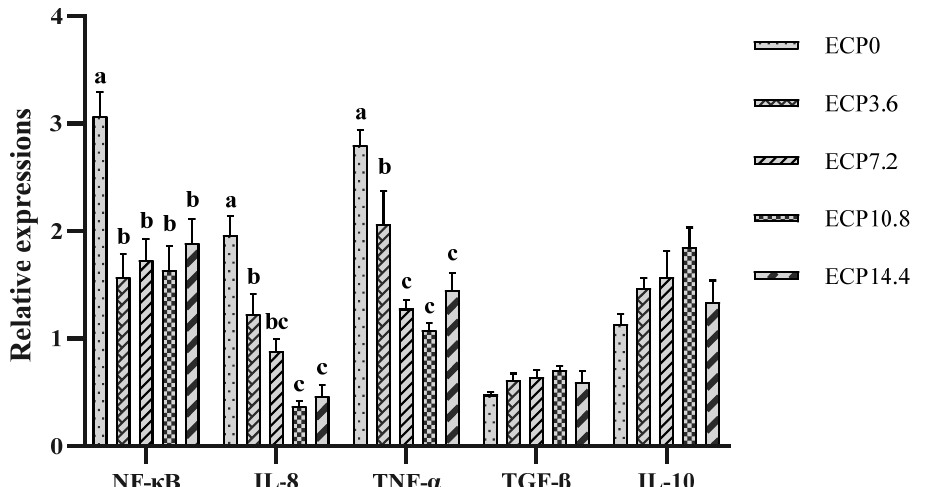
Figure 3. Relative mRNA expression levels of immune-related genes in liver. NF- κ B, nuclear factor- kappa B; IL-8, interleukin-8; TNF- α , tumor necrosis factor- α ; TGF- β , transforming growth factor- β ; IL-10, Interleukin-10. Data are presented as mean ± SD. Bars with different superscripts indicate significant differences ( p < 0.05), while that with the same letter or no letter superscripts indicate no significant differences ( p > 0.05).